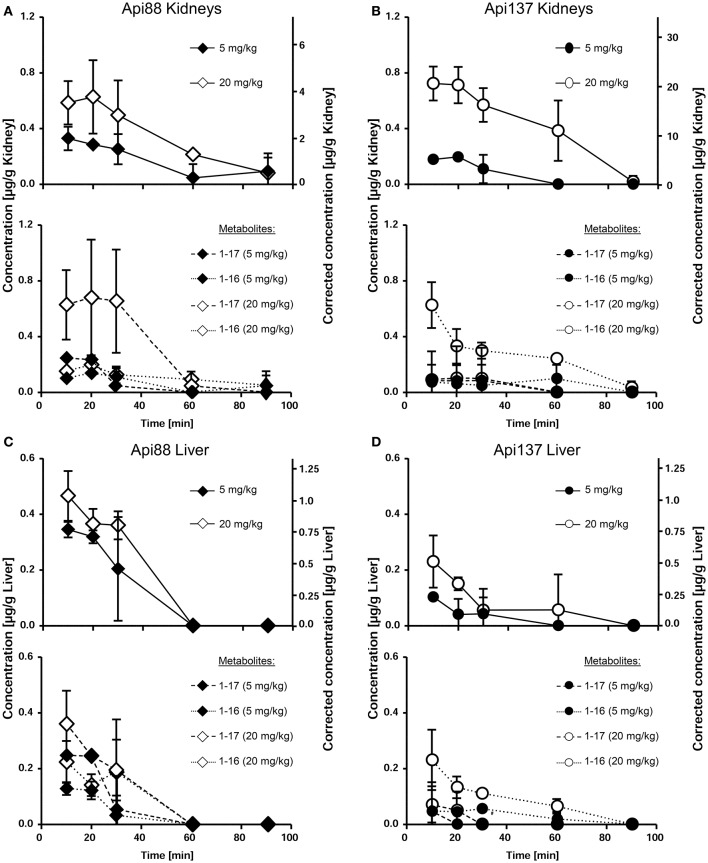
Concentration profiles of Api88 (A,C) and Api137 (B,D) and the corresponding metabolites Api1-17 and Api1-16 in kidney (A,B) and liver (C,D) homogenates. Api88 and Api137 were administered intraperitoneal (5 mg/kg and 20 mg/kg) and quantified in homogenates prepared from organs (n = 5) isolated 10, 20, 30, 60, and 90 min after administration. The hash (#) indicates that the Api1-17 value of one mouse was removed as outlier.